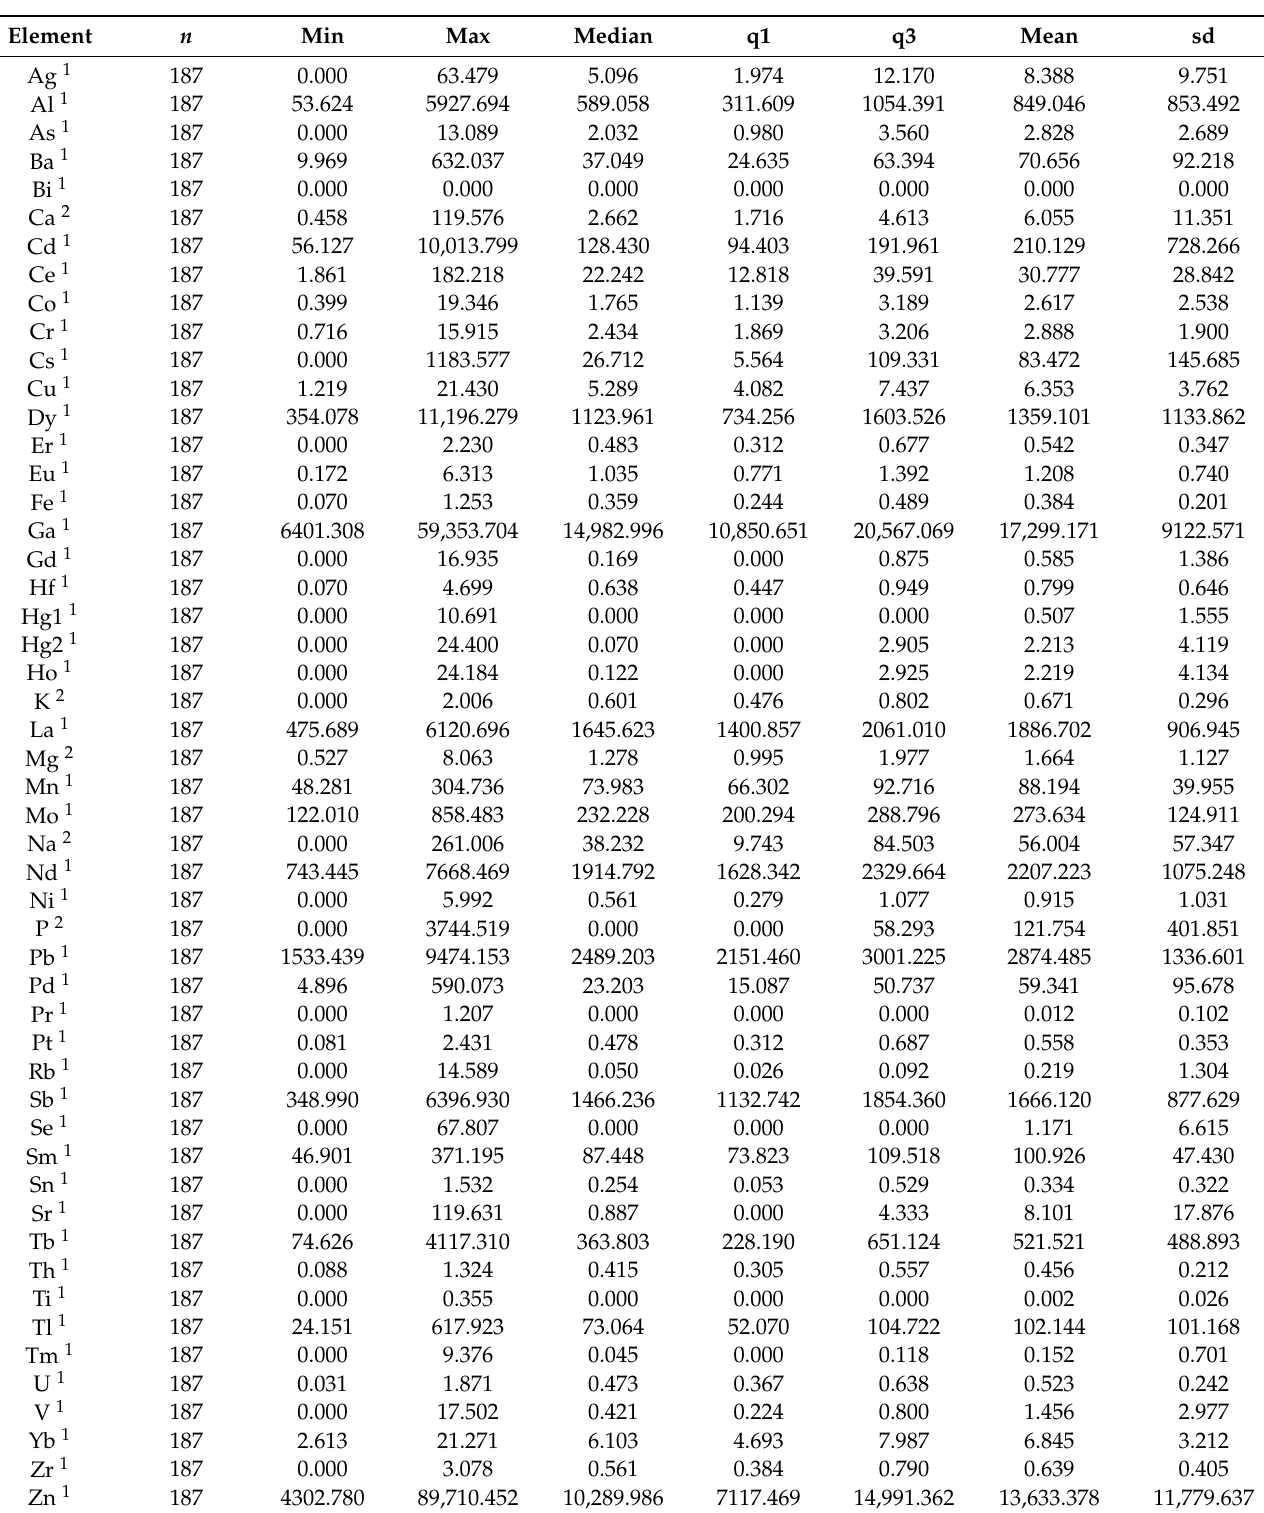
Table 2. Descriptive statistics for ICP-MS measurements of optic chiasm samples taken from the entire population of the studied subjects ( n =